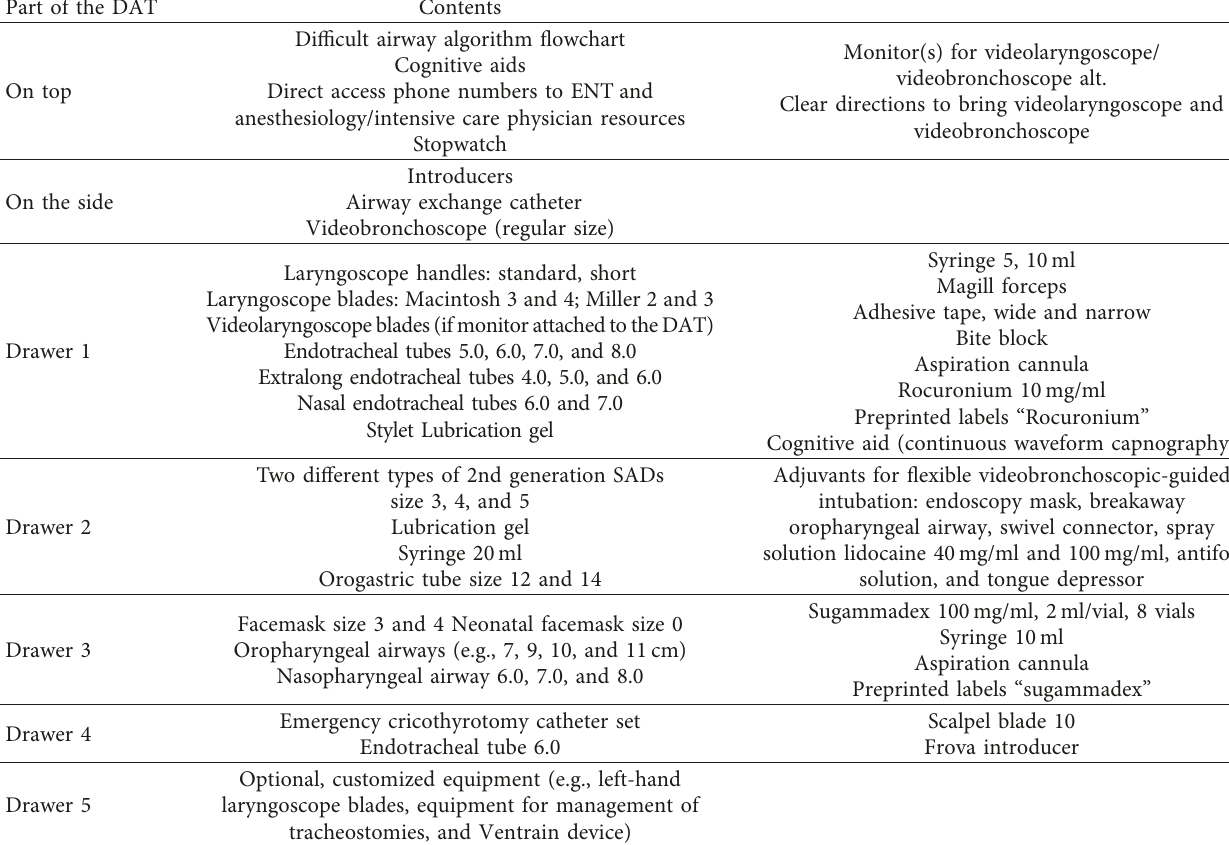
Table 2: An overview of the organization and contents of the